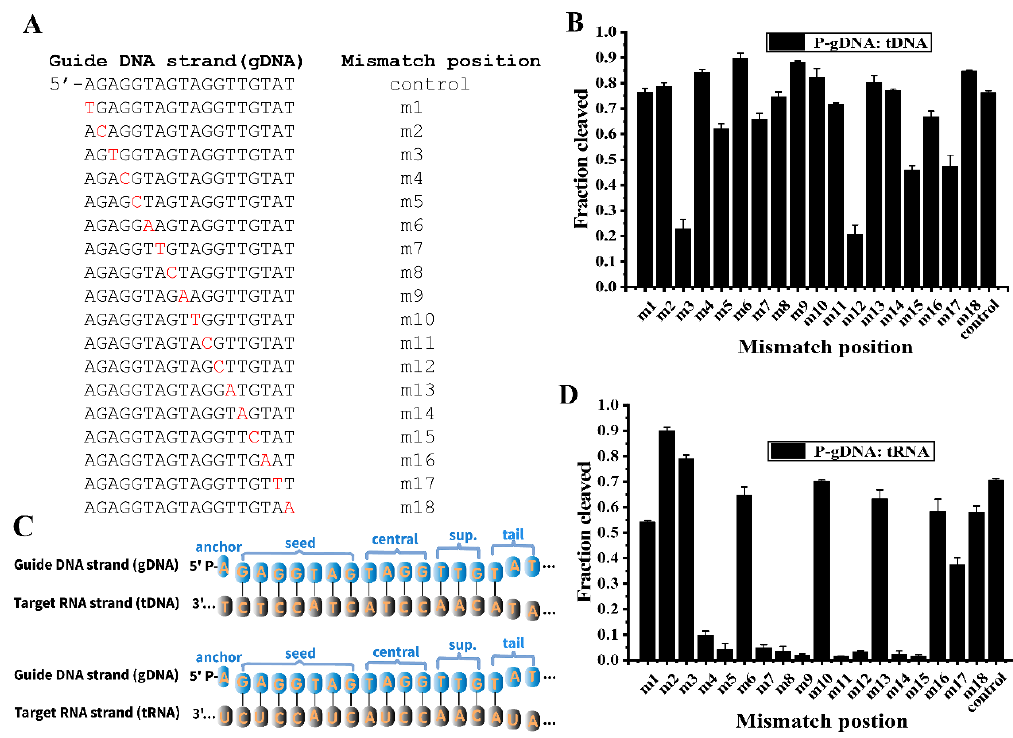
Figure 6. Effects of mismatches in the guide-target duplex on the cleavage activity of RsuAgo. ( A ) Schematic diagram of guide single nucleotide mismatch sites, mismatched positions are indicated in red. ( B ) Effects of single nucleotide mismatches in the P-gDNA: tDNA duplex on the slicing activity of RsuAgo. ( C ) Sequences of the gDNA (blue) and DNA/RNA target (grey). The different functional gDNA elements are indicated above the gDNA; sup., supplementary region. ( D ) Effects of single nucleotide mismatches in the P-gDNA: tRNA duplex on the slicing activity of RsuAgo. Control, gDNA with full complementarity to the target. All experiments were performed at the 4:2:1 RsuAgo: guide: target molar ratio in reaction buffer containing 5 mM Mn 2+ ions for 1 h at 37 °C. All cleavage experiments were carried out in triplicates and quantified. Error bars represent the SD based on three independent experiments.